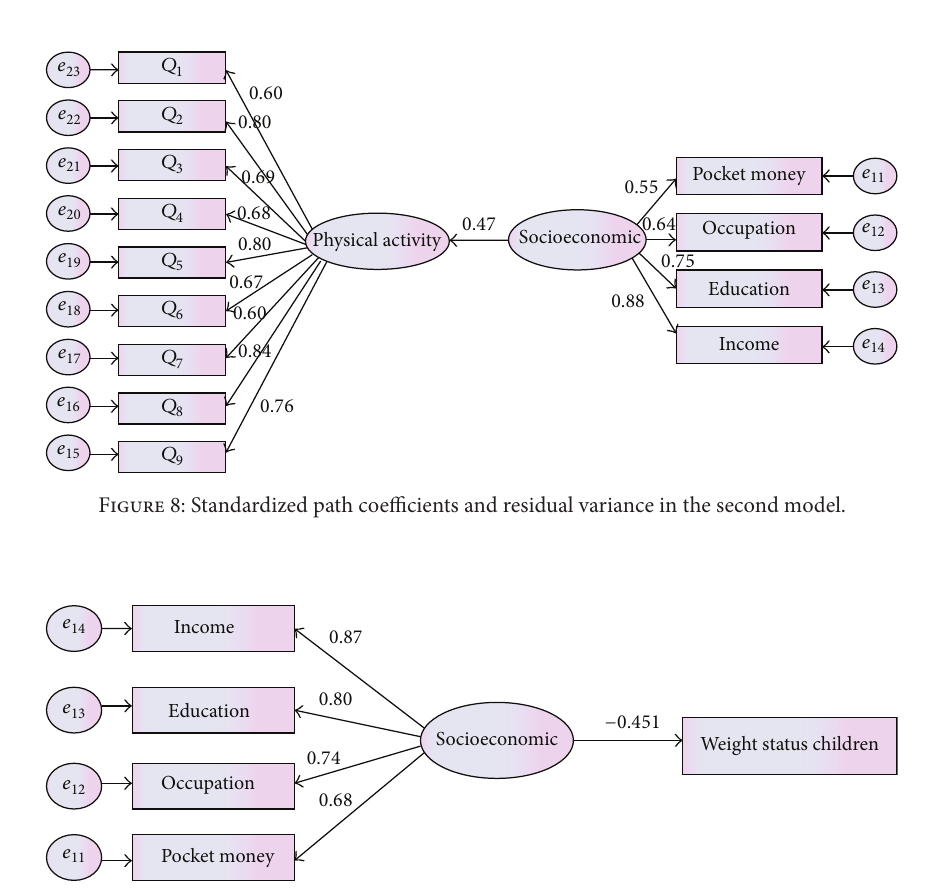
Figure 9: Standardized path coefficients and residual variance in the third